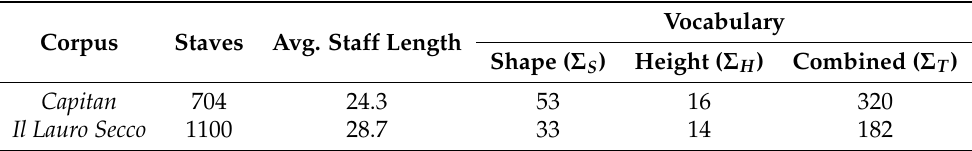
Table 1. Details of the corpora in terms of the number of staves, the average sequence length per staff, and the cardinality of the vocabulary for each label space considered. Vocabulary Corpus Staves Avg. Staff Length Shape ( Σ S ) Height ( Σ H )